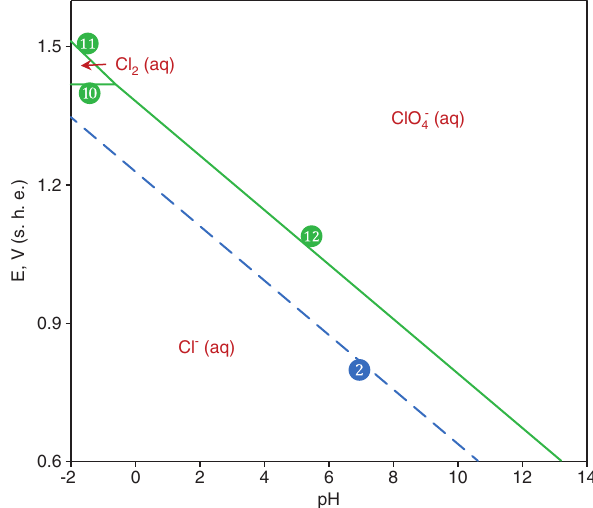
O system at 310.75 K 2